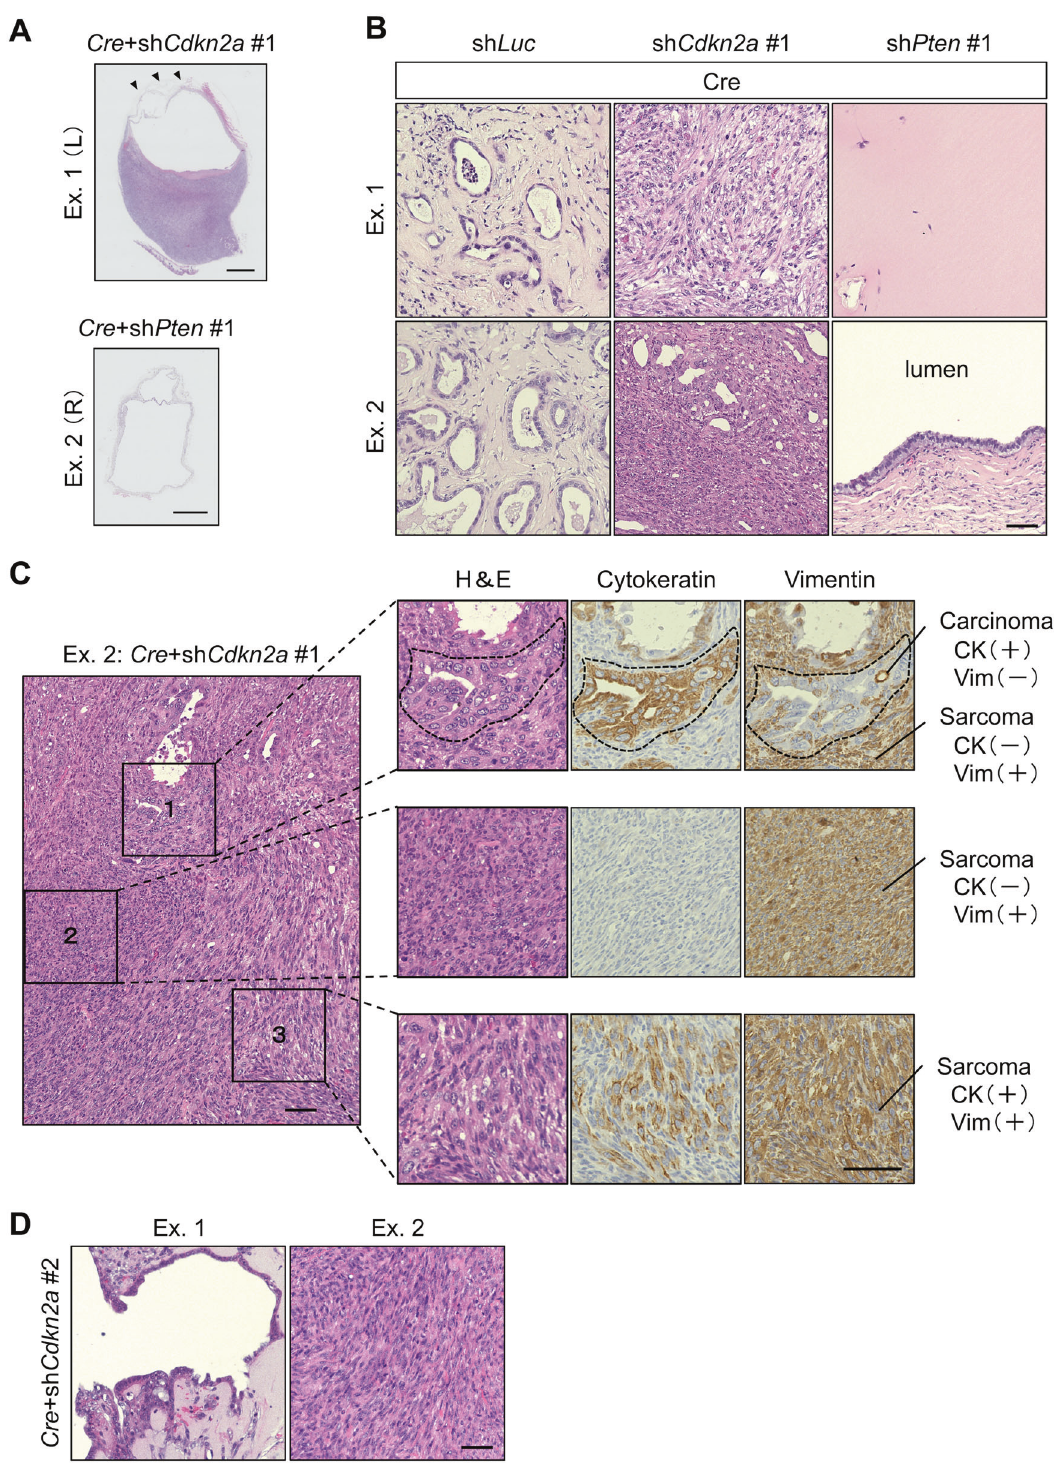
Fig. 3 Histological features of organoid-derived CS and monophasic sarcoma. (A) H&E staining of thinly sliced sections. Cre + sh Cdkn2a #1 is a sarcoma with cyst ( arrowheads ), whereas Cre + sh Pten #2 is a multilocular cyst. Scale bar, 10mm. (B) H&E staining of thinly sliced sections of subcutaneous nodules from Exs. 1 and 2. Matrigel plugs induced by Cre + sh Luc contained only a few glands with mild atypia. Tumors induced by Cre + sh Cdkn2a #1 are sarcoma in Ex. 1 and carcinosarcoma in Ex. 2. Matrigel plugs (Ex. 1) and that by Cre + sh Pten #1 is a cystic lesion (Ex. 2). Scale bar, 50 μ m. (C) Characterization of heterogeneous lesions of carcinosarcoma. H&E and IHC staining against cytokeratin and vimentin of serial sections for areas 1 – 3 are shown. Magni fi ed view of the corresponding areas is shown. Dotted lines in area 1 indicate cytokeratin + /vimentin - . Scale bar, 50 μ m. (D) H&E staining of the tumors induced by Cre + sh Cdkn2a #2. Cystic lesion from Ex. 1 and sarcoma lesion from Ex. 2 are shown. Scale bar, 50 μ